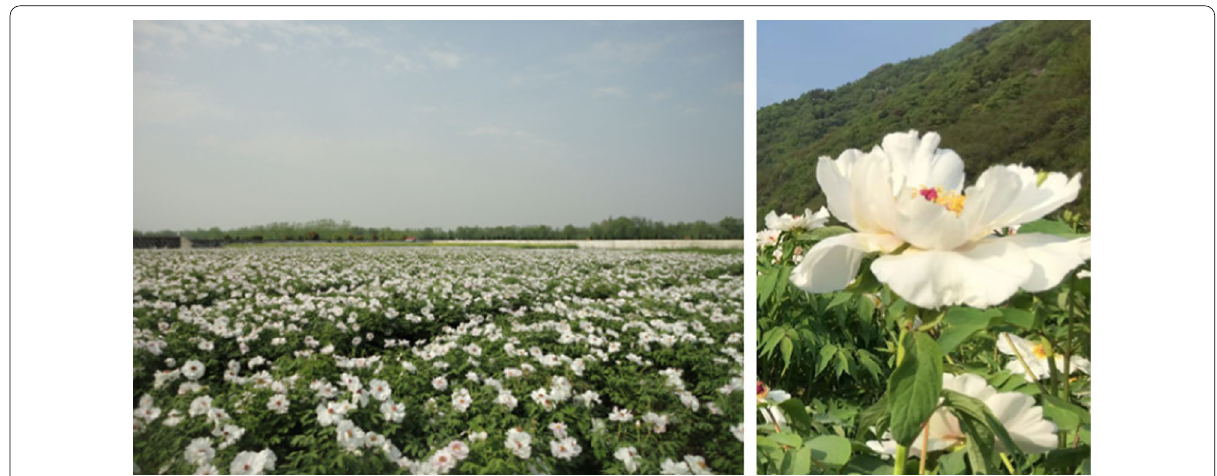
Fig. 17 Paeonia suffruticosa (“Mu Dan”, Feng Huang Mountain in Tong Ling, China)(These photos were taken by Dr. Meng Qian‑Qian)